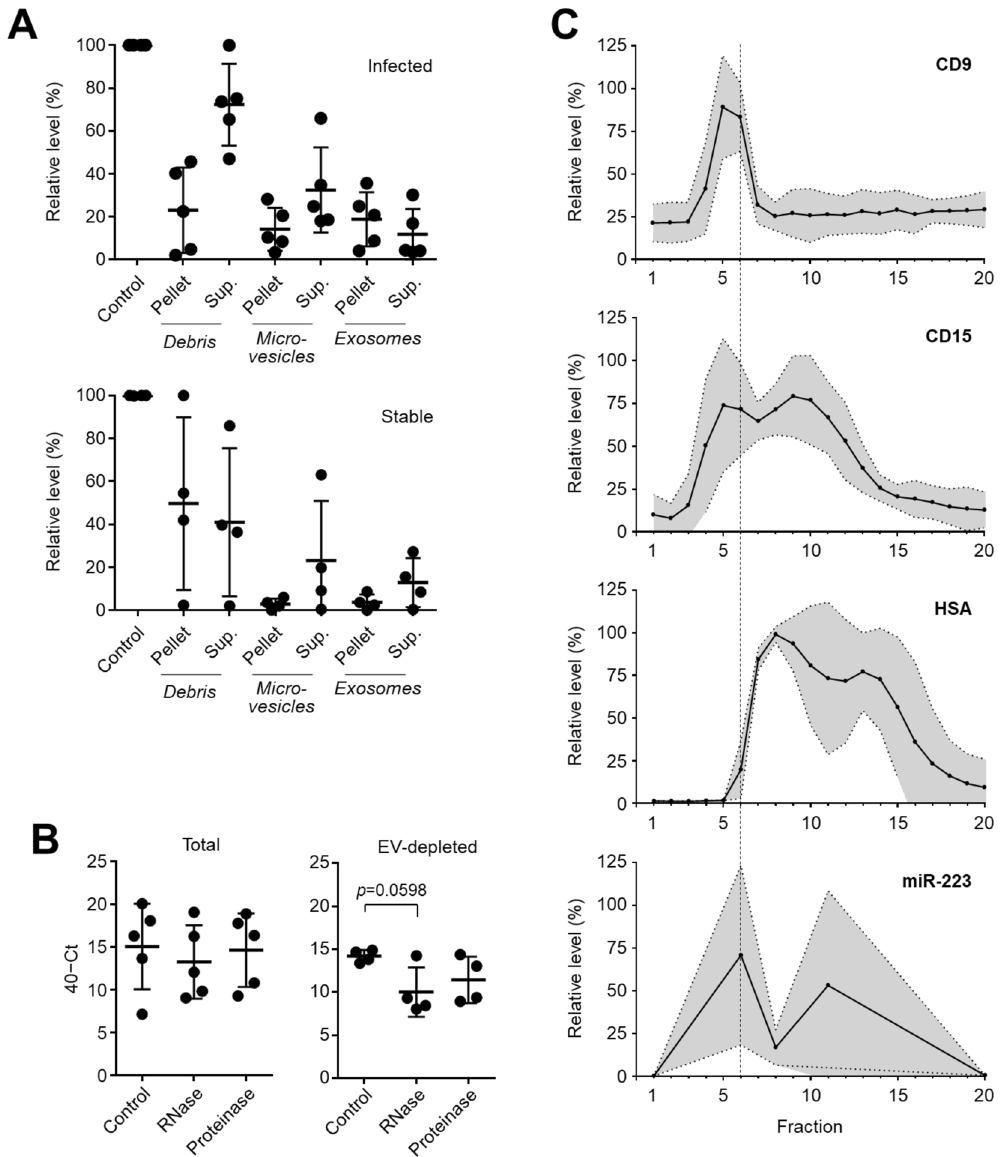
Figure 5. Stabilisation of miR-223 in PD effluent by extracellular vesicles. ( A ) miR-223 levels in cell-free effluent from infected (top, n = 5) and stable (bottom, n = 4) PD patients, before (control) and after differential centrifugation to pellet cellular debris, larger microvesicles and smaller exosomes. Data are shown as mean values ± SD, in relation to the amount of miR-223 present in the unspun effluent (control) serving as reference. ( B ) Susceptibility of extracellular miR-223 in effluent from infected PD patients to RNase A and proteinase K treatment, before (left, n = 5) and after (right, n = 4) depletion of exosomes. Each data point corresponds to an individual patient, shown as raw 40 − Ct values; lines indicate means and standard deviations. Statistical analysis was performed using Kruskal-Wallis tests combined with Dunn’s multiple comparisons tests. ( C ) Fractionation of cell-free effluent from five infected PD patients by size exclusion chromatography and detection of CD9, CD15 and human serum albumin (HSA) in each fraction using plate-bound immunoassays. miR-223 was only quantified in fractions 1, 6 (marked by the dashed line), 11 and 20. Graphs depict the relative levels of each marker compared to the fraction containing the maximum amount; lines show the means and the shaded areas the 95% confidence Our data suggest that miR-223 is mainly released by local immune cells which infiltrate the peritoneum upon infection, corroborating earlier reports that this microRNA is predominantly expressed by cells from the myeloid lineage 16 . The high expression by infiltrating neutrophils and macrophages agrees with the large increase of miR-223 levels in cell-free PD effluent in acute peritonitis as well as in experimental peritonitis in mice, and the subsequent decay in parallel with the resolution of the inflammatory response. These findings evoke earlier studies implicating miR-223 as biomarker for diagnosis or progression in a range of conditions. For instance, miR-223 is increased in sepsis and rheumatoid arthritis, as well as in viral infections and animal models of bacterial infections 17,18 . Of